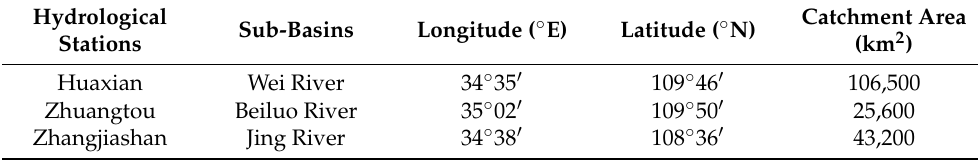
Table 3. Basic information of the hydrological station in the study